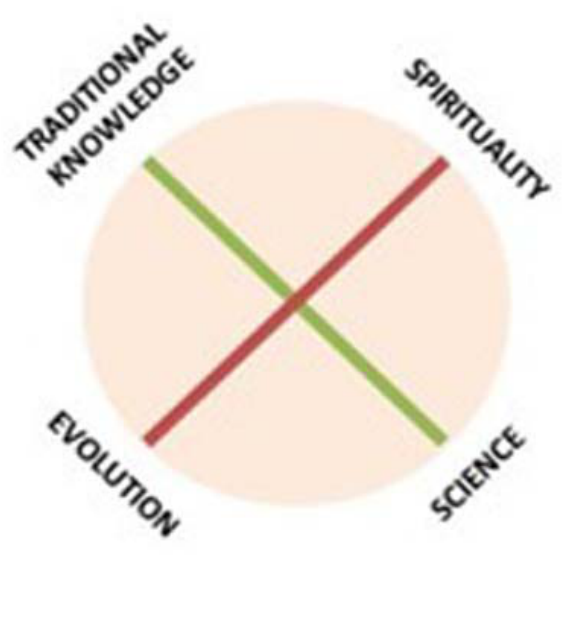
Fig. 1. Adapted from a workshop on biodiversity (NPS 2016) as a representation of how we may connect singular perspectives to become pluralistic in our approach to integrating biological diversity with cultural diversity. The co-production reflects that “There can be at least two ways of knowing (through science and traditional knowledge) and at least two ways of understanding (through spirituality and evolution).” Singular positions connected visually in a unity of opposites heuristic allowed the conversation to pivot from an individual to a collective approach through mutual